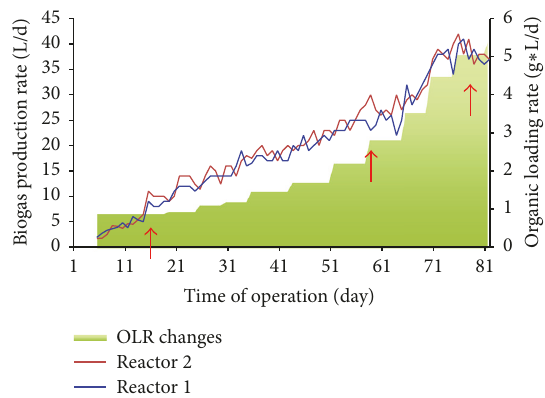
Figure1:BiogasproductionrateandchangesintheOLRduringAD of microalgae and sodium acetate in two reactors. Arrows point to the days, when sludge samples were